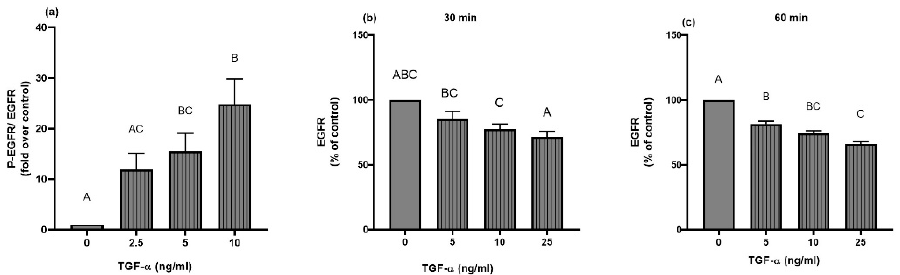
Figure 8. TGF- α induces EGFR phosphorylation and endocytosis. A549 cells were stimulated with different TGF- α concentrations (2.5 ng/mL, 5 ng/mL, 10 ng/mL) for one hour, then EGFR phosphorylation at Tyrosine 1068 was measured with Western blotting and normalized to pan EGFR ( a ). Data for n = 6 independent experiments are presented as means + SEM. EGFR surface expression was determined by flow cytometry upon stimulation with different concentrations of TGF- α (5 ng/mL, 10 ng/mL, 25 ng/mL) for 30 min ( b ) and 60 min ( c ). Data were normalized to the control sample. Data for n = 3 independent experiments are shown as means + SEM. Statistical significances between data sets were calculated by using one-way ANOVA and Tukey’s post hoc test ( p < 0.05). The same letter is never shared by statistically different data sets.